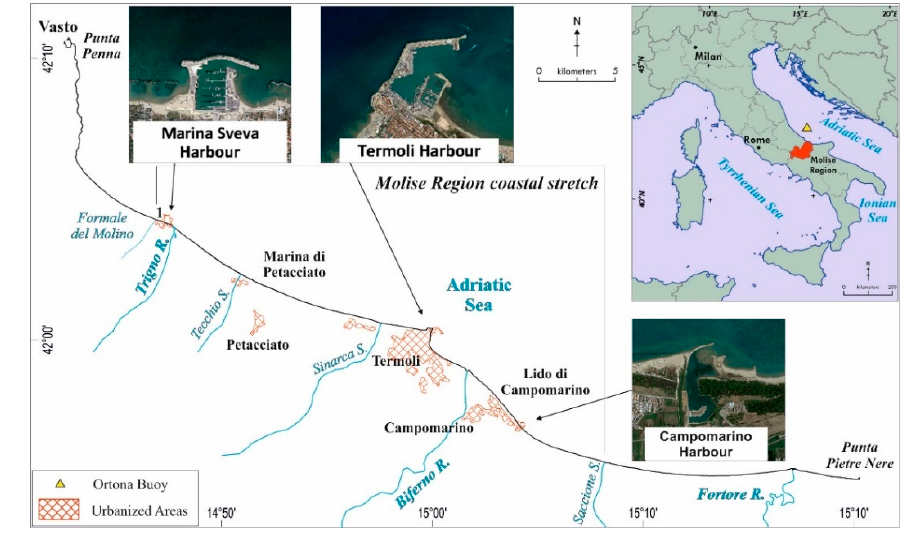
Figure 1. Molise coast with the main harbor location.